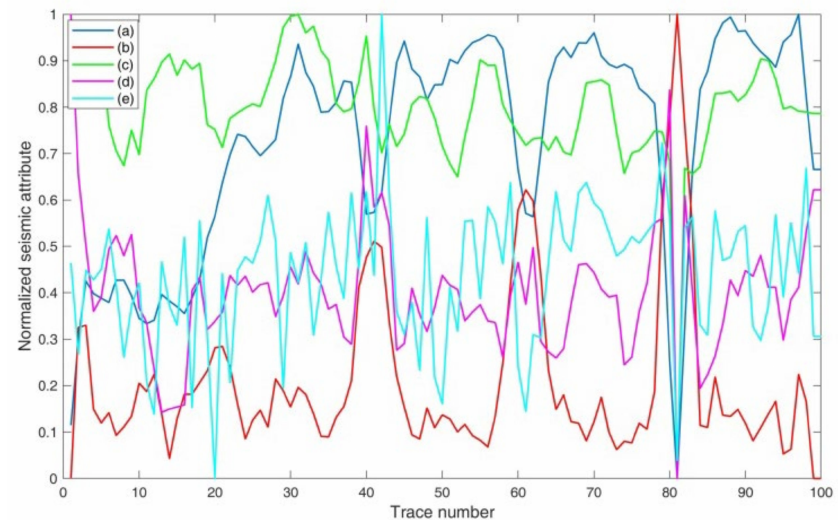
Figure 9. Normalization of the seismic attributes of the synthetic seismogram with noise (after VMD denoising): ( a ) instantaneous amplitude attribute; ( b ) waveform difference attribute; ( c ) instantaneous frequency attribute; ( d ) frequency bandwidth attribute; and ( e ) attenuation coefficient